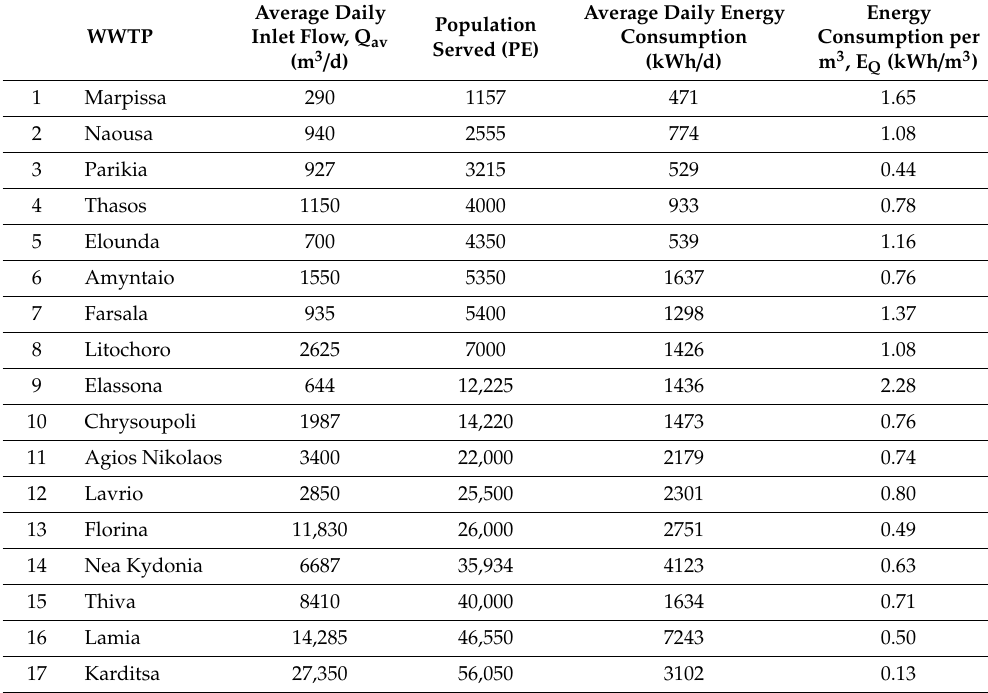
Table 2. Average daily inflow, population served, average daily energy consumption and energy consumption per m 3 for the studied